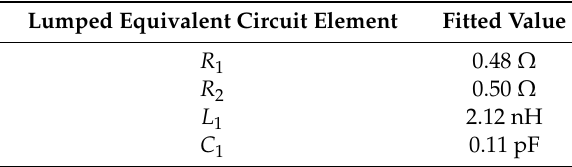
Table 2. Values of the element of the lumped equivalent circuit (Figure 6) obtained by fitting.